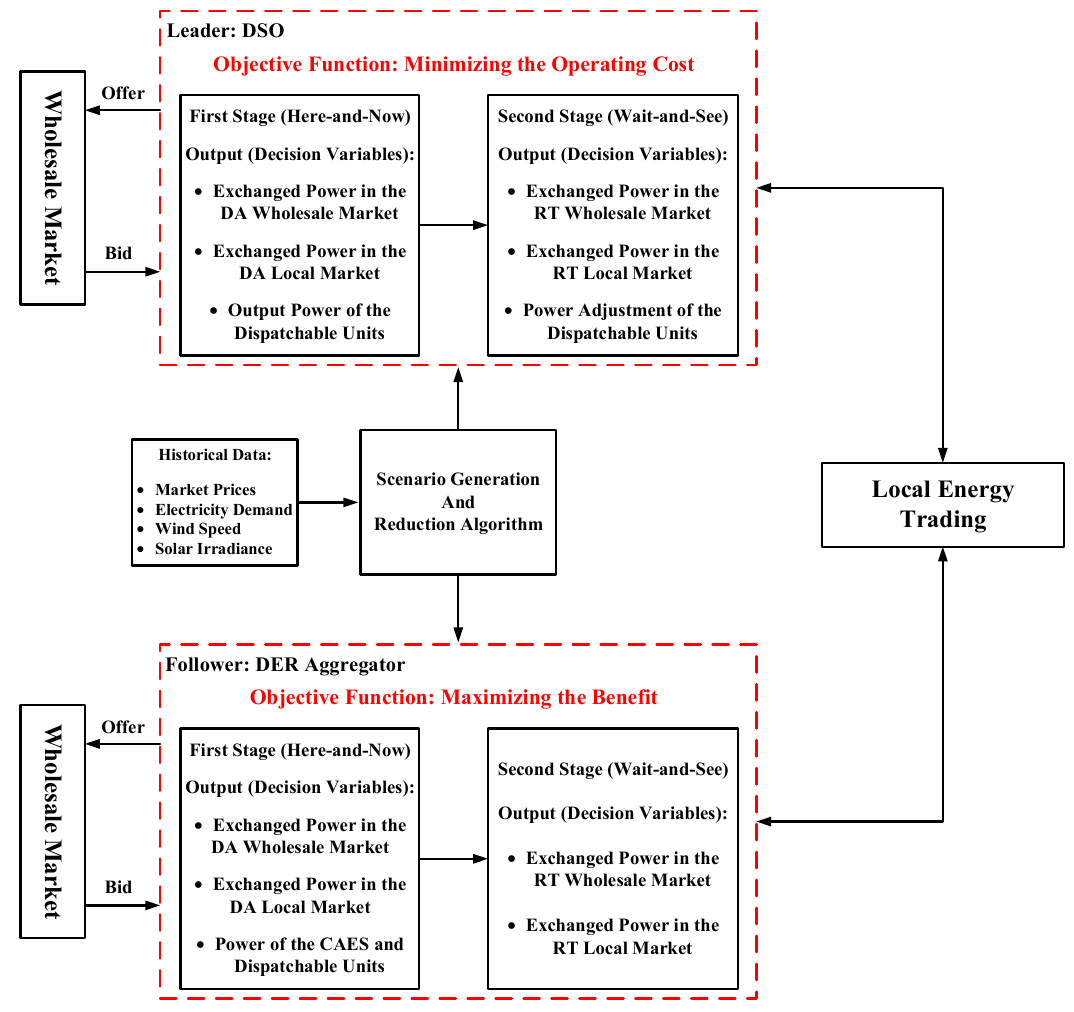
Figure 1. Scheme of the proposed model.